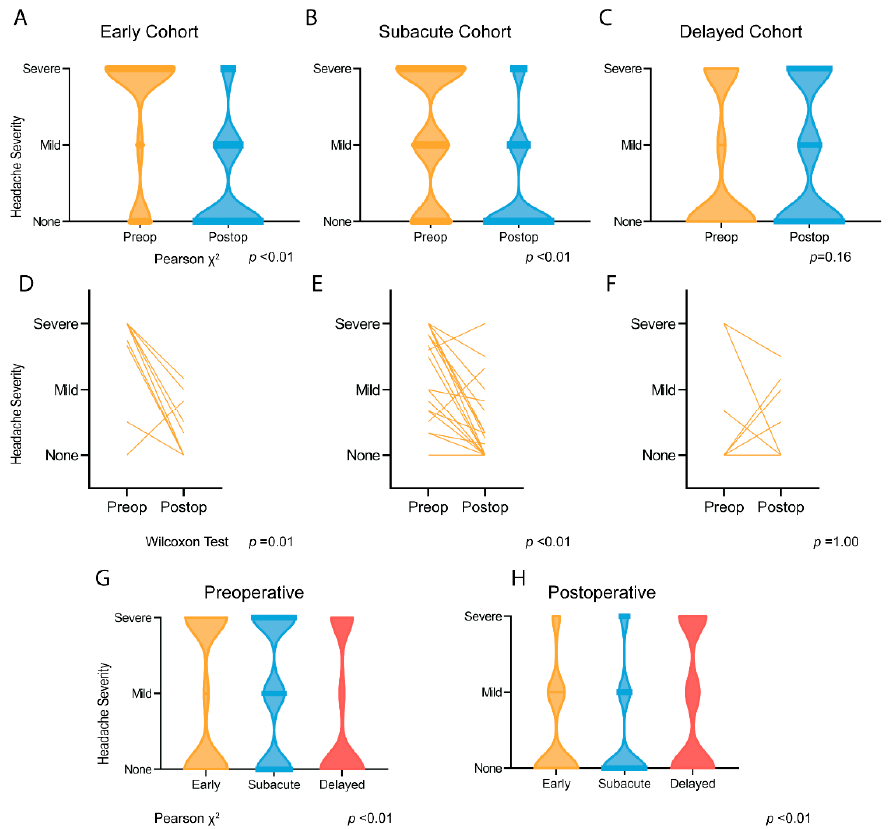
Figure 1. Pre- and Postoperative Headaches. Distributions of severity of headaches pre- and postoperatively in early ( A ), subacute ( B ), and delayed ( C ) cohorts. Individual subjects’ headache scores pre- and postoperatively in early ( D ), subacute ( E ), and delayed ( F ) cohorts. Distributions of headache severity by cohort in preoperative ( G ) and postoperative ( H ) time periods.